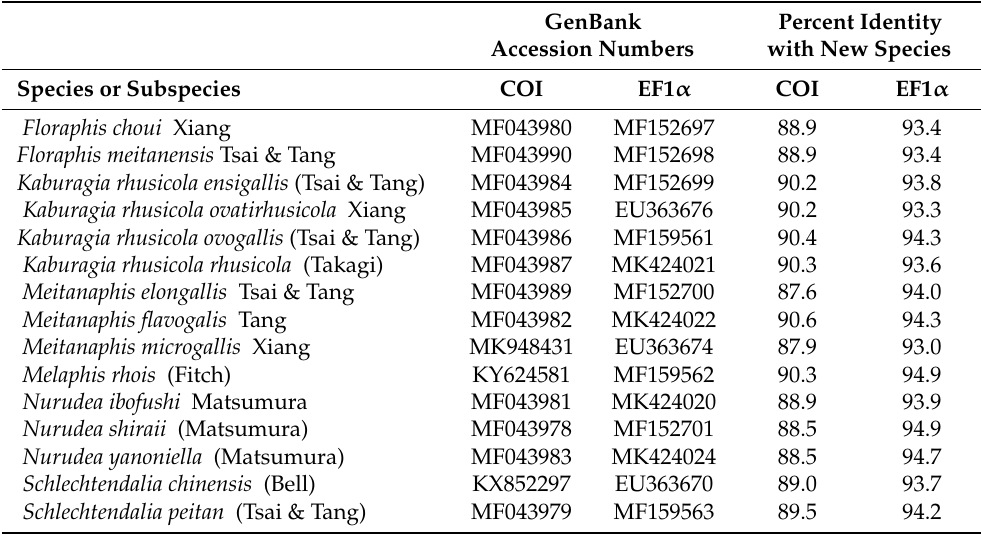
Table 1. Species compared in this study with their GenBank accession numbers for COI and EF1 α